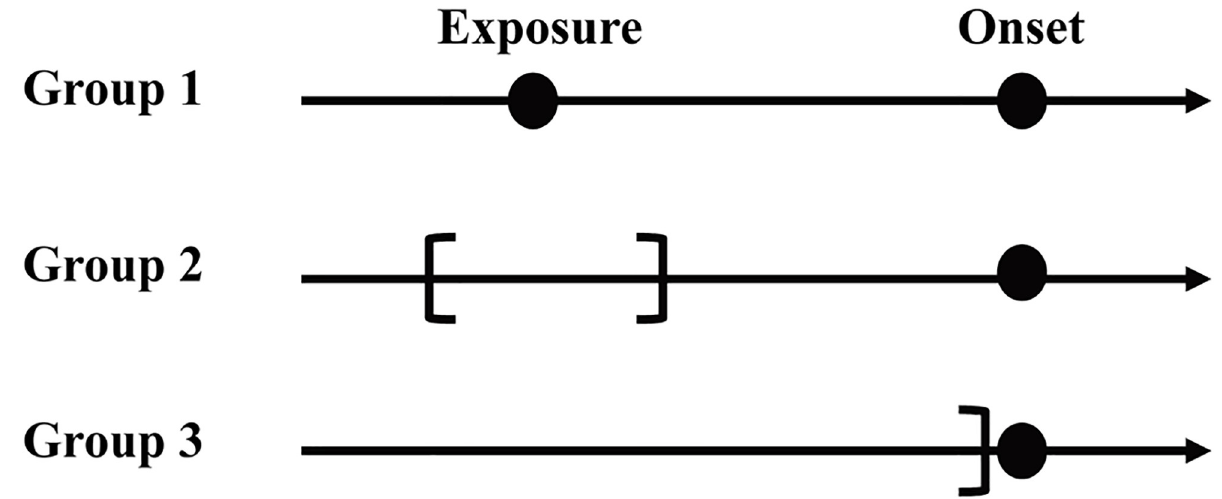
Fig 1. Illustrated time of exposure and classification of cases. In the present study, diagnosed cases of dengue virus fell into one of three groups. In Group 1, the exact date of exposure was known. In Group 2, exposure dates were interval censored, calling for interval-censored likelihood. In Group 3, no information was available with respect to time of exposure. Depending on this grouping, we used slightly different likelihood functions.